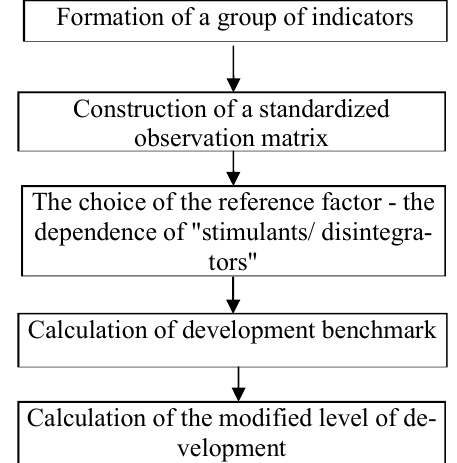
Fig. 1. Algorithm of the modified development level